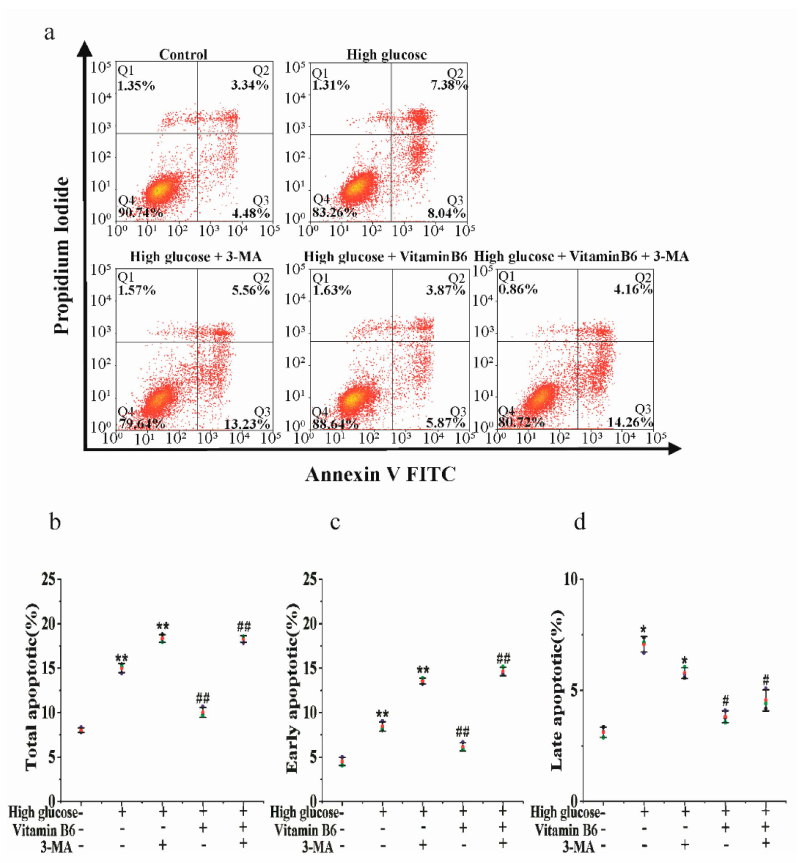
Figure 7. Vitamin B6 protected RIN-m5F cells from apoptosis by inducing autophagy under high glucose stress. ( a ) RIN-m5F cells were cultured with or without 20 mM glucose or with 20 mM glucose plus 10 mM 3-MA, 20 mM glucose plus 20 µ M vitamin B6, or 20 mM glucose plus 10 mM 3-MA plus 20 µ M vitamin B6, and the apoptosis rate was measured by flow cytometry. ( b – d ) Cells were treated as described in ( a ), and total apoptosis, late apoptosis, and early apoptosis rates were analyzed. The experiment was repeated at least three times (Error bars, SD.; ** p < 0.01, * p < 0.05 indicates significant differences compared with the control group by one-way ANOVA. ## p < 0.01, # p < 0.05 indicates significant differences compared to the vitamin B6 plus high glucose-treated group by one-way